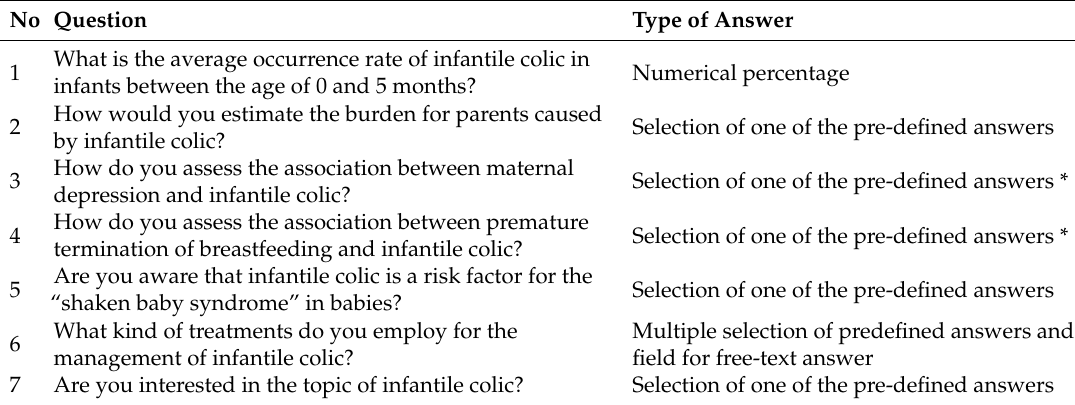
Table 1. Questions of the